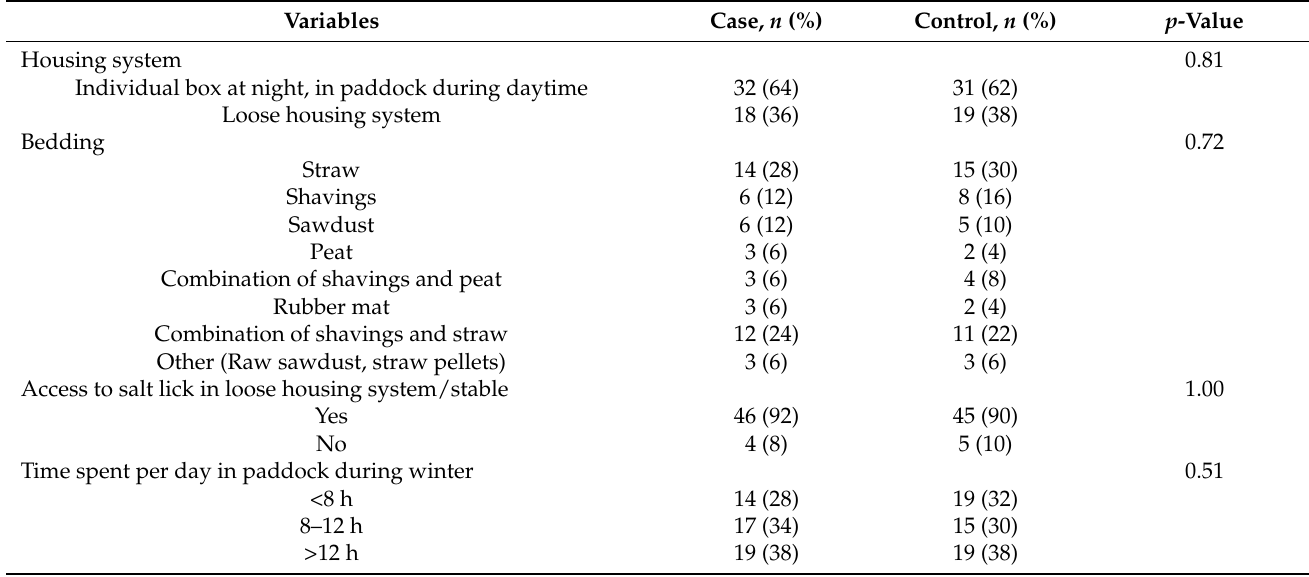
Table 5. Distribution of management strategies of farm-matched pairs of horses with (case, n = 50) and without (control, n = 50) free faecal